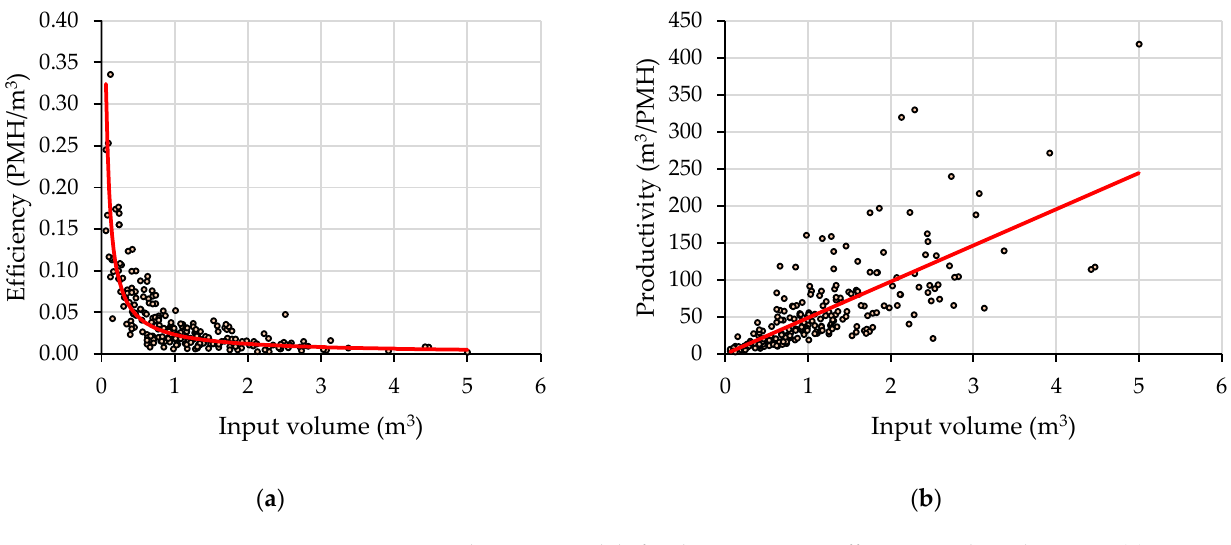
Figure 4. Best explanatory models for the variation in efficiency and productivity: ( a ) variation in efficiency as a function of input volume, ( b ) variation in productivity as a function of input volume.